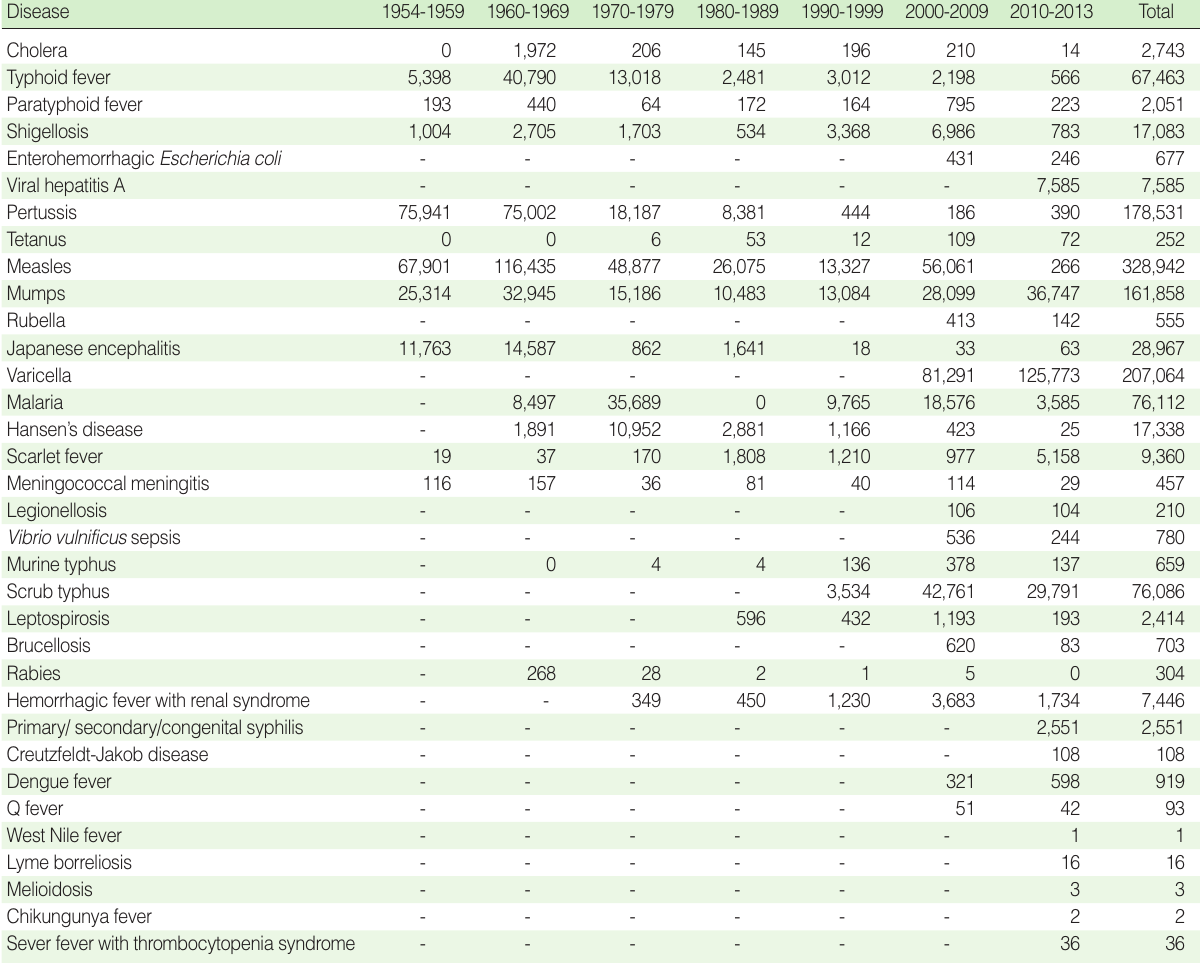
Table 1. Reported cases of national infectious diseases in South Korea, 1954-2013 Disease